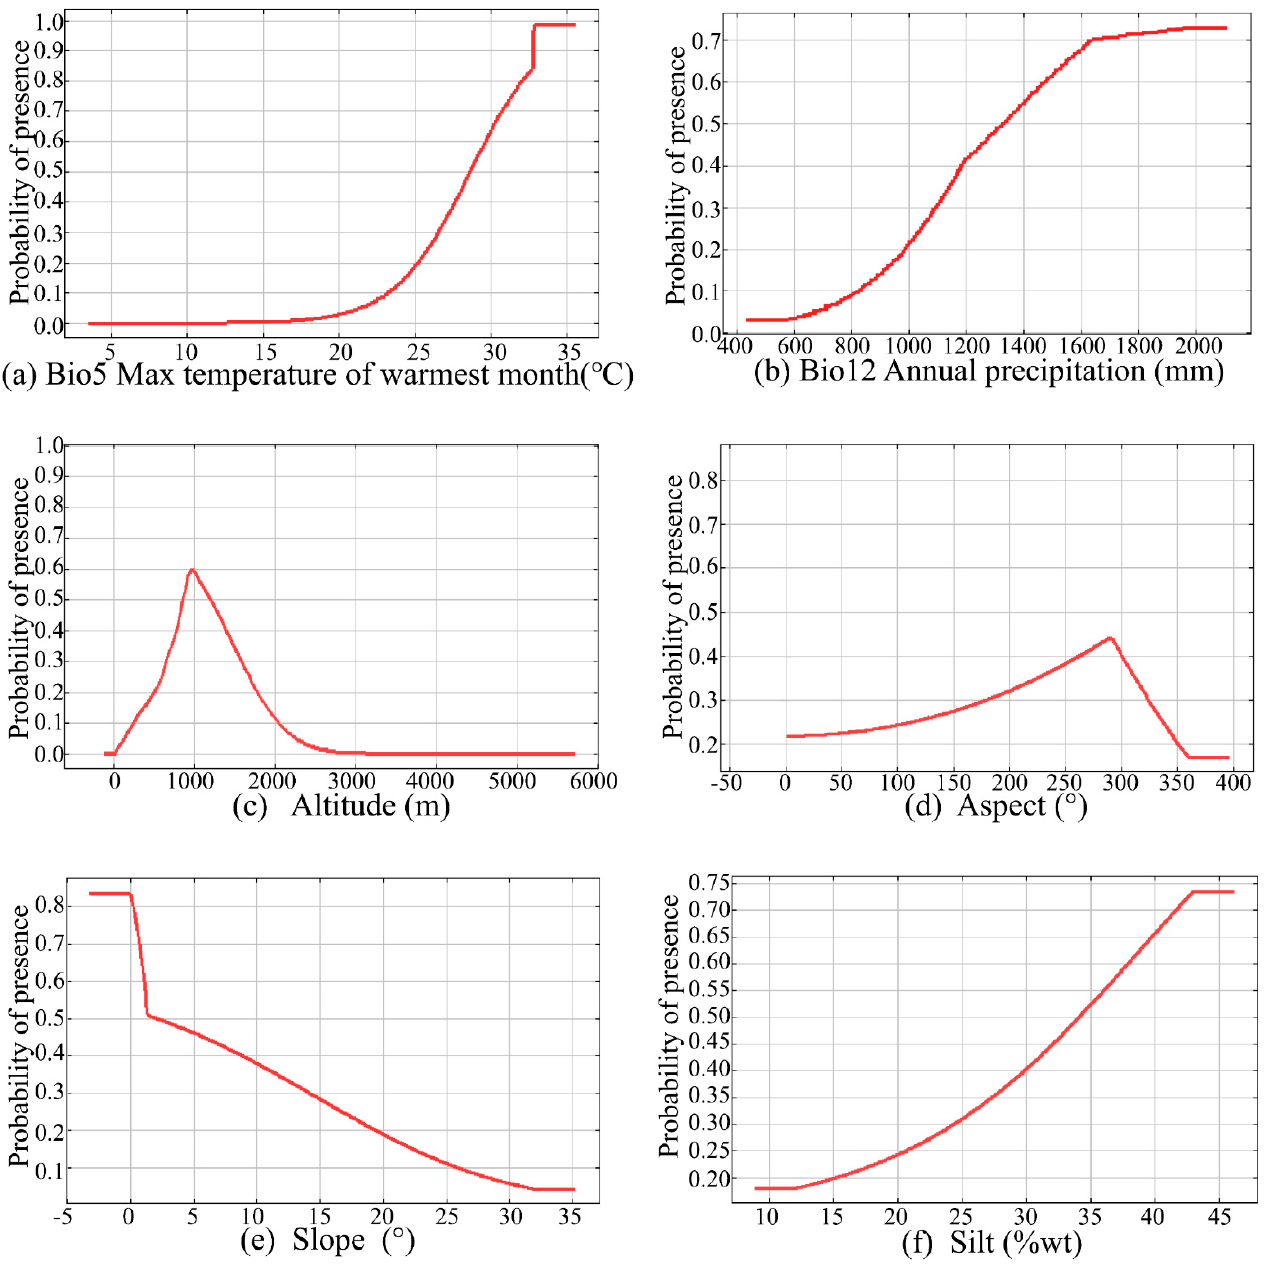
Figure 7. Response curves of six important factors that influence Arabica Coffee distribution. (Bio5-max temperature of warmest month, Bio12-annual precipitation, altitude, aspect, slope and silt). Table 3. Potentially suitable areas for Arabica Coffea under the current and future scenarios